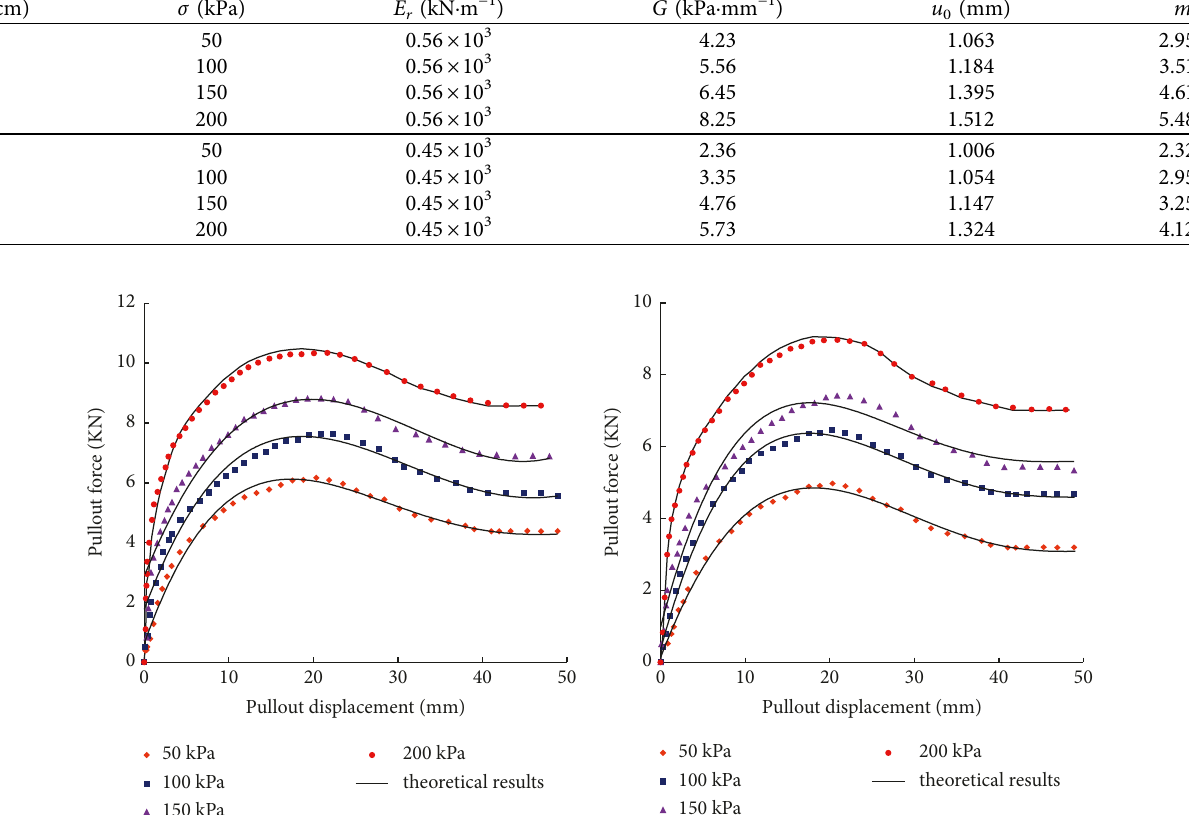
Table 4: Model parameters of geogrid-soil interface.